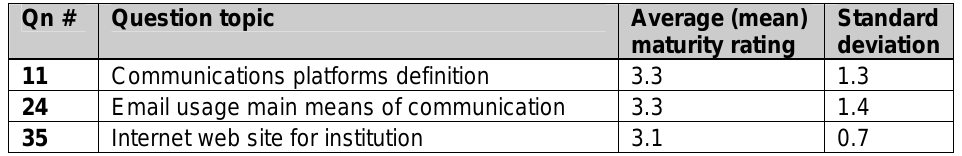
Table 5: Survey responses by mean maturity